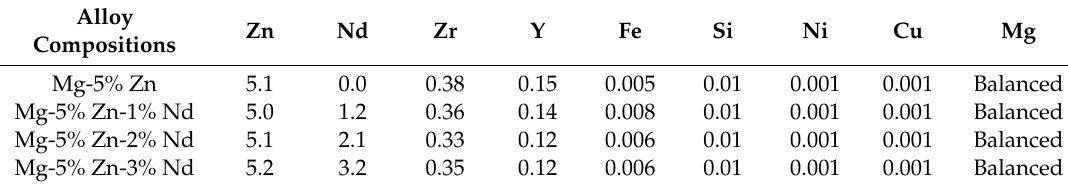
Table 1. Chemical composition of the tested alloys (in wt%) (data from